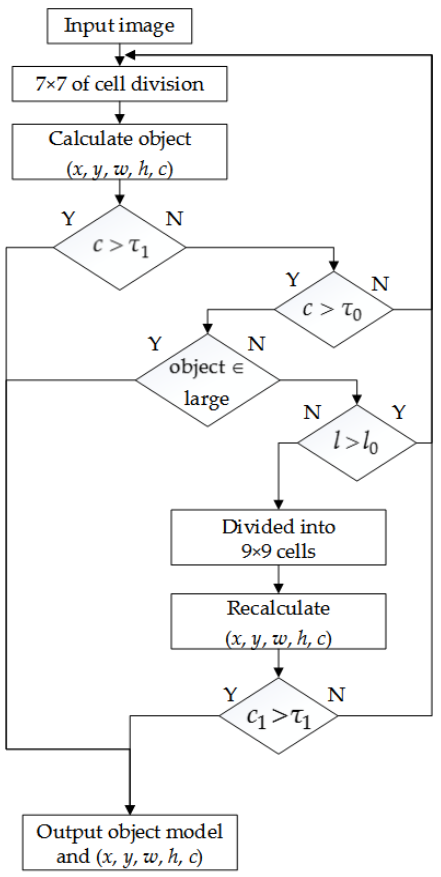
Figure 4. The flow chart of secondary image detection program. Object ∈ large means that targets are {bus, car, truck}.